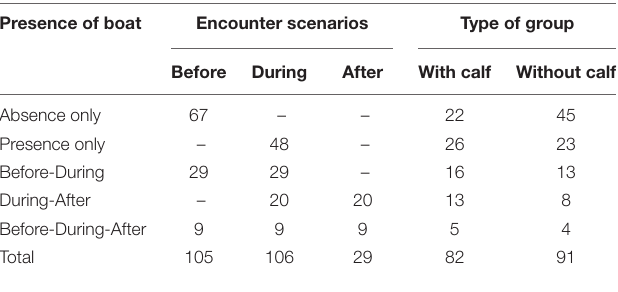
TABLE 1 | Summary of the number of tracks registered per scenario and type of group (with/without calf). Presence of boat